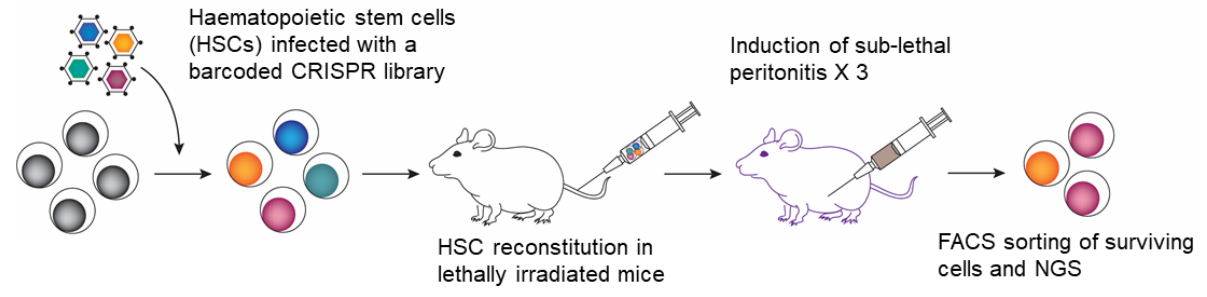
FIGURE 1: The schematic explaining the whole-genome CRISPR screening in mice to identify gene(s) involved in immune cell death during polymicrobial